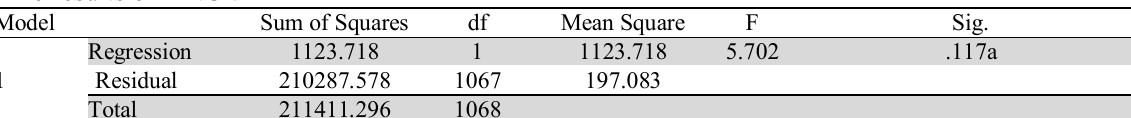
The results of ANOVA b